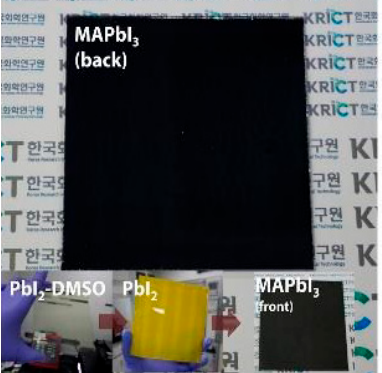
Figure 5. Picture of 100 cm 2 perovskite thin film produced by slot-die coating. Copyright Repro- duced with permission from Reference [3].